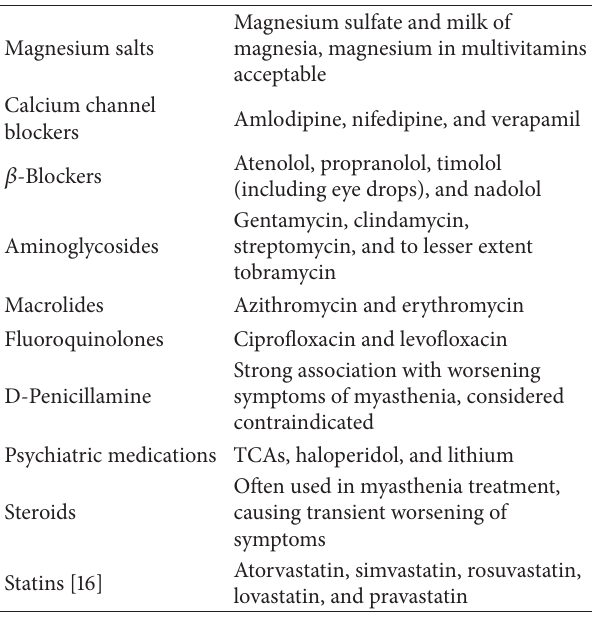
Table 2: Medications with associated exacerbations of myasthenia